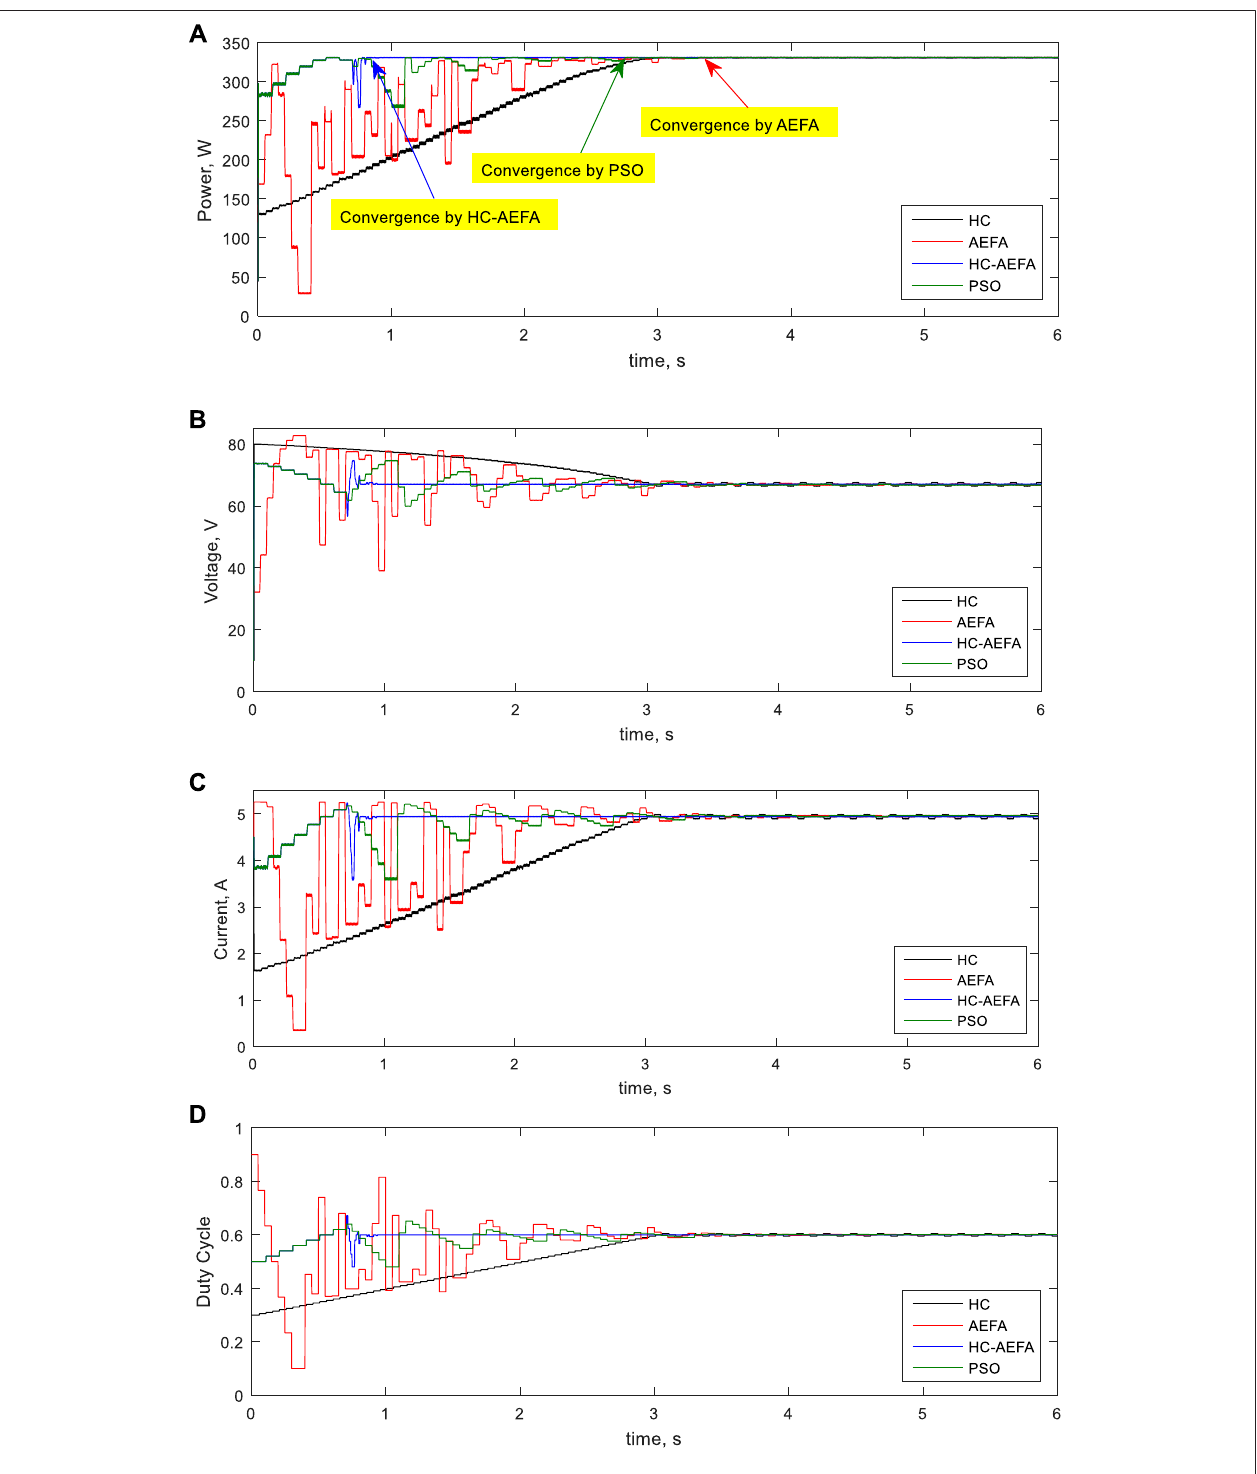
FIGURE4| Simulation waveformsatthe fi rstpatternobtainedusing theHC-AEFA, HC,AEFA,and PSOmethods; (A) PVoutput power, (B) PVoutput voltage, (C) PV output current, and (D) converter duty-cycle curves.